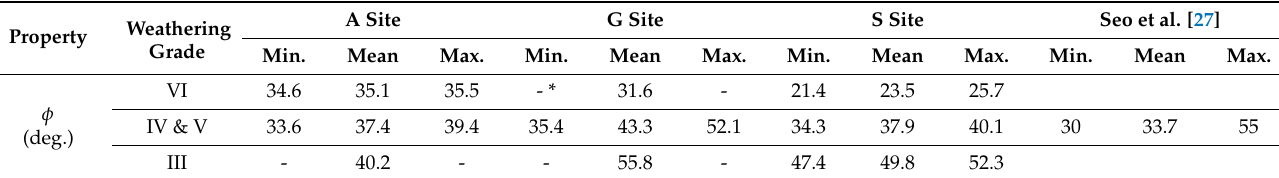
Table 2. Friction angles estimated by limit pressure.